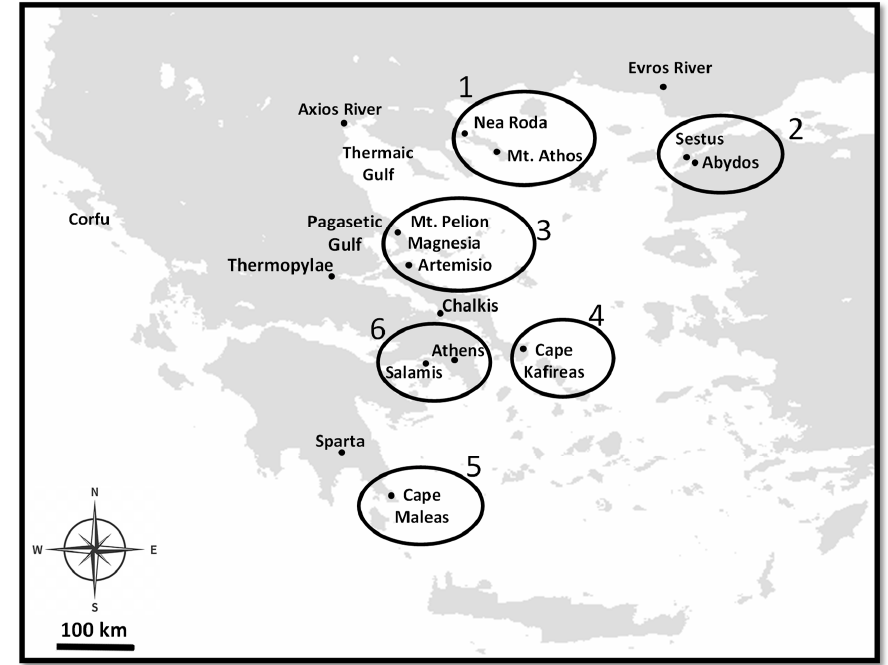
Figure 1. Weather related events during the Persian invasions in Greece. (1) Mardonius’ fleet is completely destroyed by a storm at Mt. Athos in 492 B.C.; (2) storm and gale winds prevent Xerxes’ army from crossing into Europe (481 B.C.); (3) gale-force northeast winds and heavy seas lasting for three days destroy three hundred triremes and dozens of other ships (480 B.C.); (4) two hundred Persian ships were wrecked by strong winds at Cape Kafireas in their attempt to approach Athens from the open sea (480 B.C.); (5) the Greeks from Corfu fail to join the allied Greek forces in Salamis due to strong winds at Cape Maleas (480 B.C.); (6) naval battle at Salamis. Subsequently, the Persian marine and land forces met at the Evros estuary (Figure 1) and Xerxes himself inspected the fleet [2] (7, 128). The triremes counted were one thousand two hundred and seven, while the total of the rest of the ships amounted to three thousand [2] (7, 21). The Persian fleet sailed in parallel to the advancing land troops, until they reached the Axios estuary at the Thermaic Gulf, where all Persian land forces gathered (Figure 1). The Greeks, in their attempt to intercept the Persian invasion, decided to occupy Thermopylae with their land forces and Artemisio (Figure 1) with their fleet [2] (7, 175). Eleven days after the Persian fleet had set sail from the Thermaic Gulf, it arrived at the coast of Magnesia (see Figure 1). The next day, gale-force northeast winds (i.e., Etesians) brought about very heavy seas which lasted for three days [2] (7, 188). It is estimated that three hundred triremes and dozens of smaller ships were lost, while larger vessels were carried away by the winds and the heavy seas to the coasts of Pelion. It is obvious that the disaster caught the Persians off guard and, in panic, those of them who survived set sail to the southeast end of Magnesia, where they anchored in the Pagasetic Gulf (Figure 1). The Greeks, who were informed by the day scouts about the Persian fleet damage, returned at the highest possible speed from Chalkis to Artemisio (Figure 1), so that they would arrive there earlier than the Persian ships. As a matter of fact, they also captured fifteen of them [2] (7, 8); [3]; [4] (8, 15). Another two hundred Persian ships attempting to circumnavigate Euboea were lamentably wrecked at Cape Kafireas (Figure 1). At the same time the Greek army was defeated at Thermopylae and the Greek fleet set sail south to protect the southern regions [4] (8, 21). The Persian fleet anchored in Artemisio and they stayed there for several days,